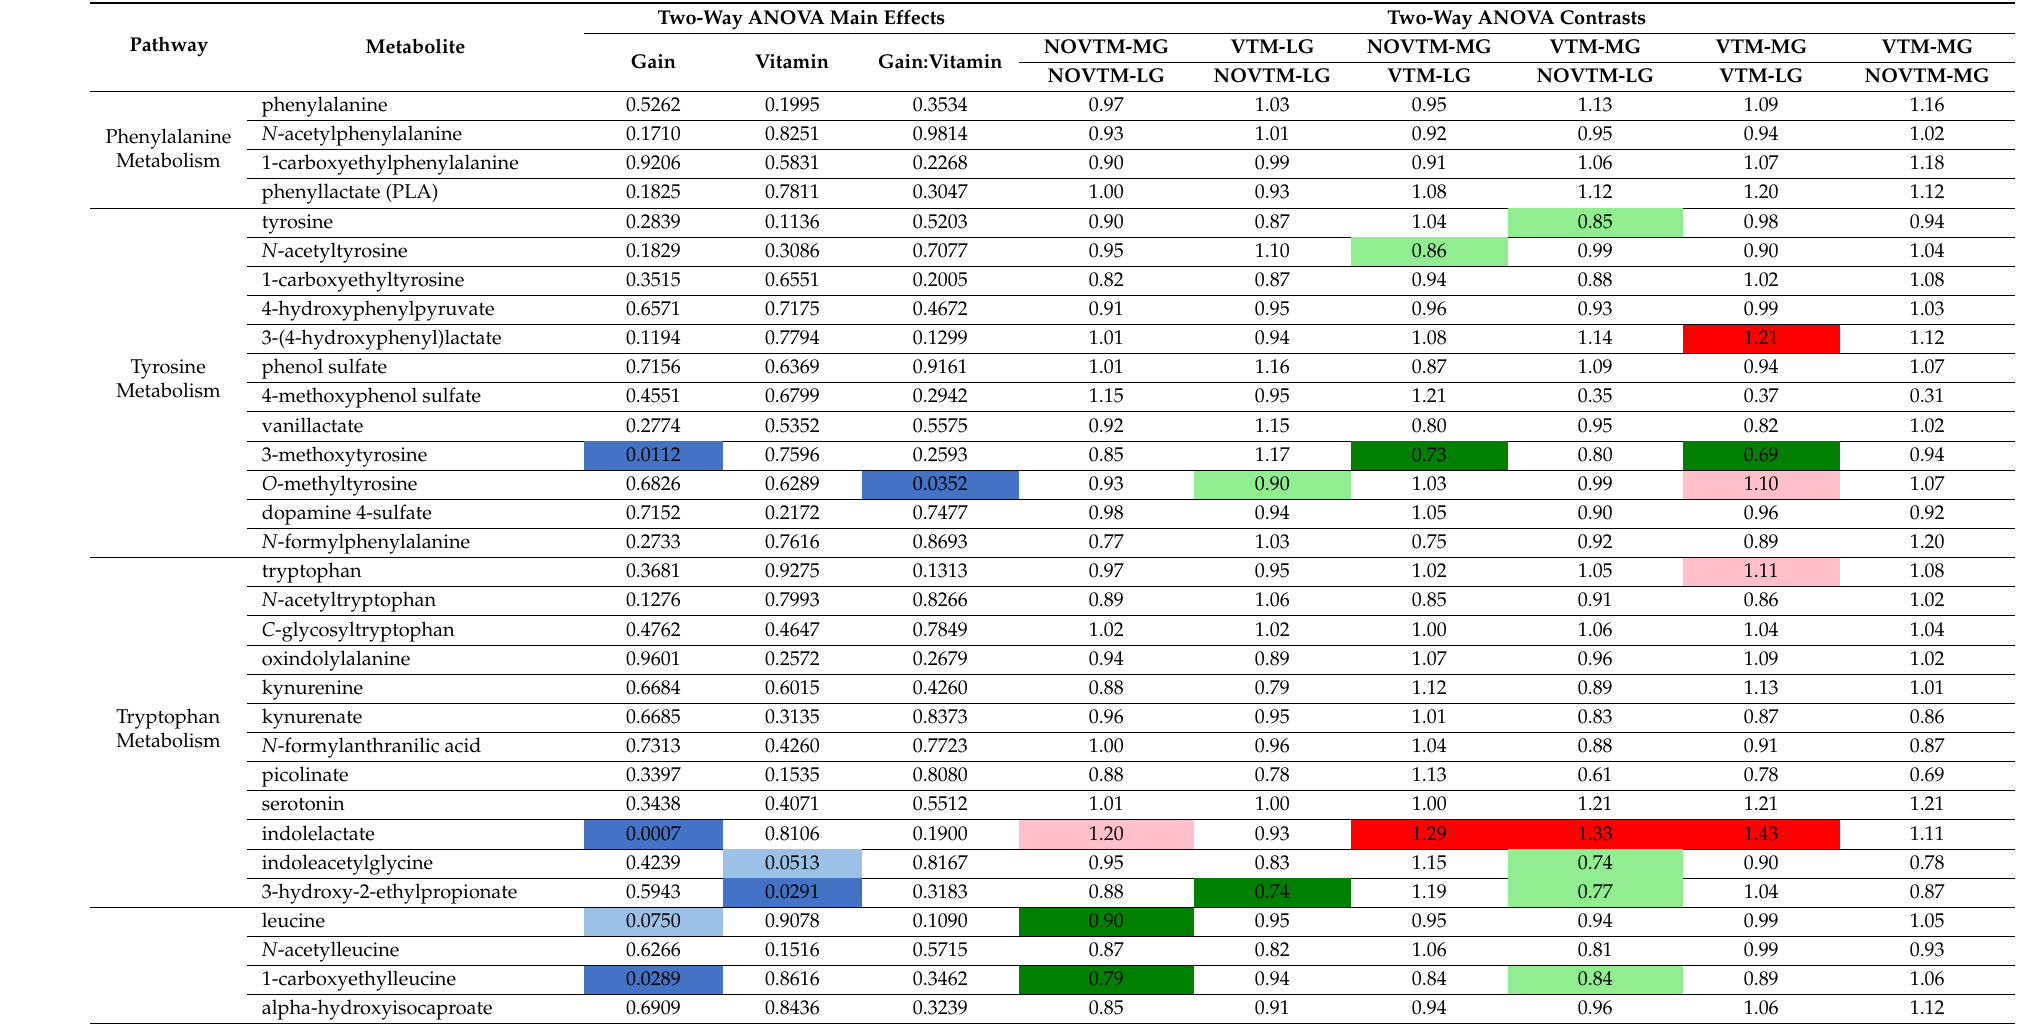
Table 3. Metabolites involved in amino acid metabolism pathways: (1) Phenylalanine, (2) Tyrosine, (3) Tryptophan, (4) Leucine, Isoleucine, and Valine, and (5) Methionine, Cysteine, SAM, and Taurine